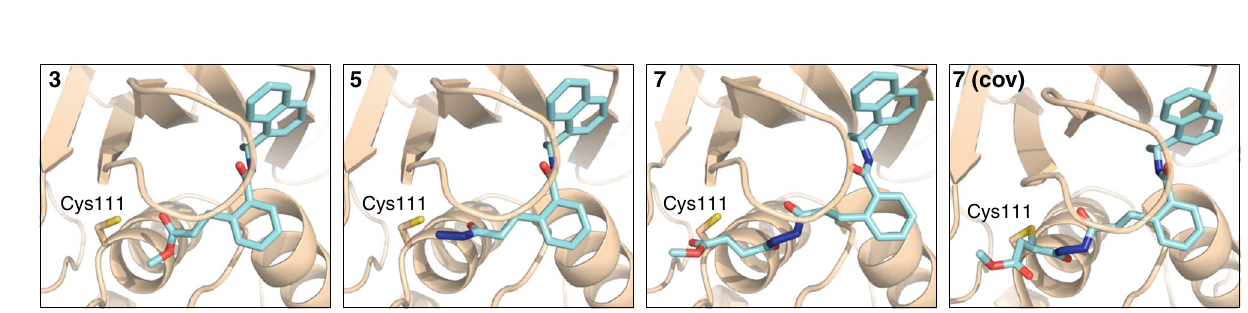
Fig.3|Dockedposesofcompounds3,5,and7. Compound 7 wasdockedbothnoncovalentlyandcovalently.StructuresofcompoundsareshowninFig.4.Dockedposes for additional inhibitor candidates are shown in Supplementary Fig. 2. Ligand carbons are shown in cyan. Hydrogens were omitted for